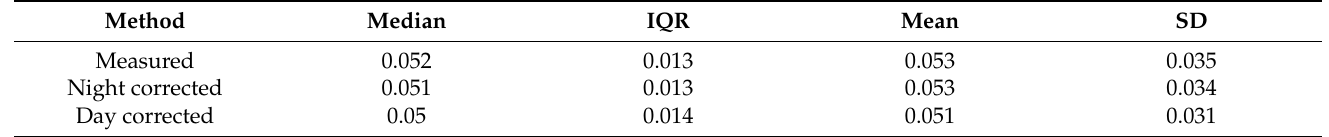
Table 4. K d [ m − 1 ] calculated on good daytime profiles, all λ , for measurements where 0.1